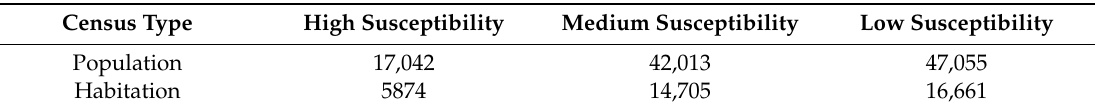
Table 5. The total number of estimated population and habitations (according to the census of 2010) located in flood-prone areas to be a ff ected by floods with three di ff erent degrees of susceptibility: high, medium, and low.